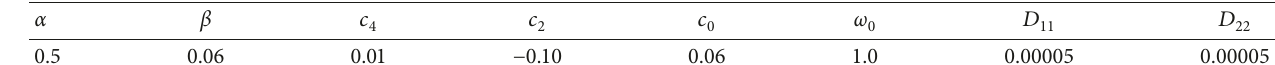
Table 3: Parameter values used in simulation.